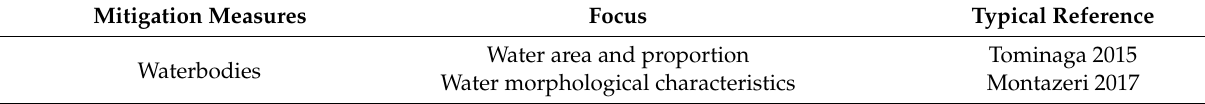
Table 5. Research on control methods for the urban thermal environment based on CFD. Mitigation